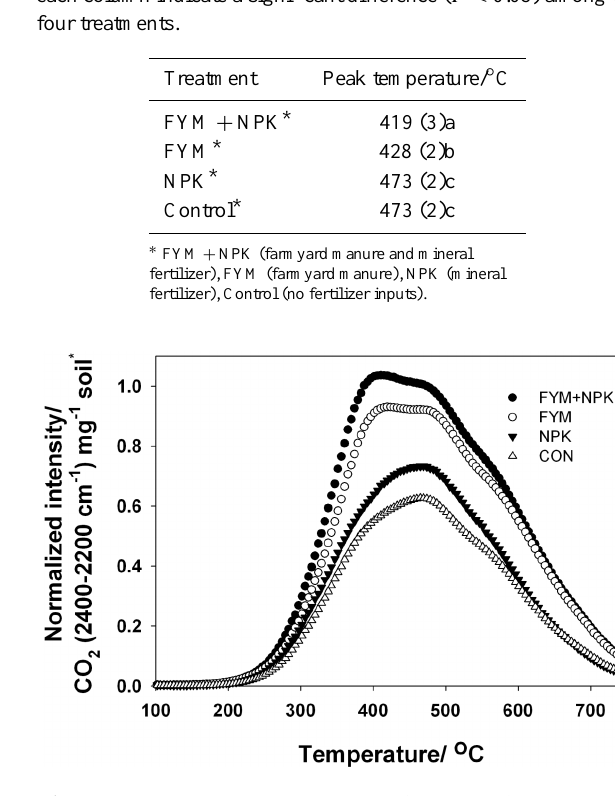
Figure 6 Fig. 6. FTIR-EGA CO 2 thermograms of bulk soil from the Static Fertilization Experiment, Bad Lauchst¨adt, heating from 25 to 700 ◦ C at 68 ◦ Cmin − 1 under synthetic air purge. Treatments: FYM + NPK (farmyard manure and mineral fertilizer), FYM (farm- yard manure), NPK (mineral fertilizer), CON (no fertilizer inputs). ∗ Normalized intensity is the integrated area of the CO 2 peak from 2400 to 2200cm − 1 normalized to weight of the